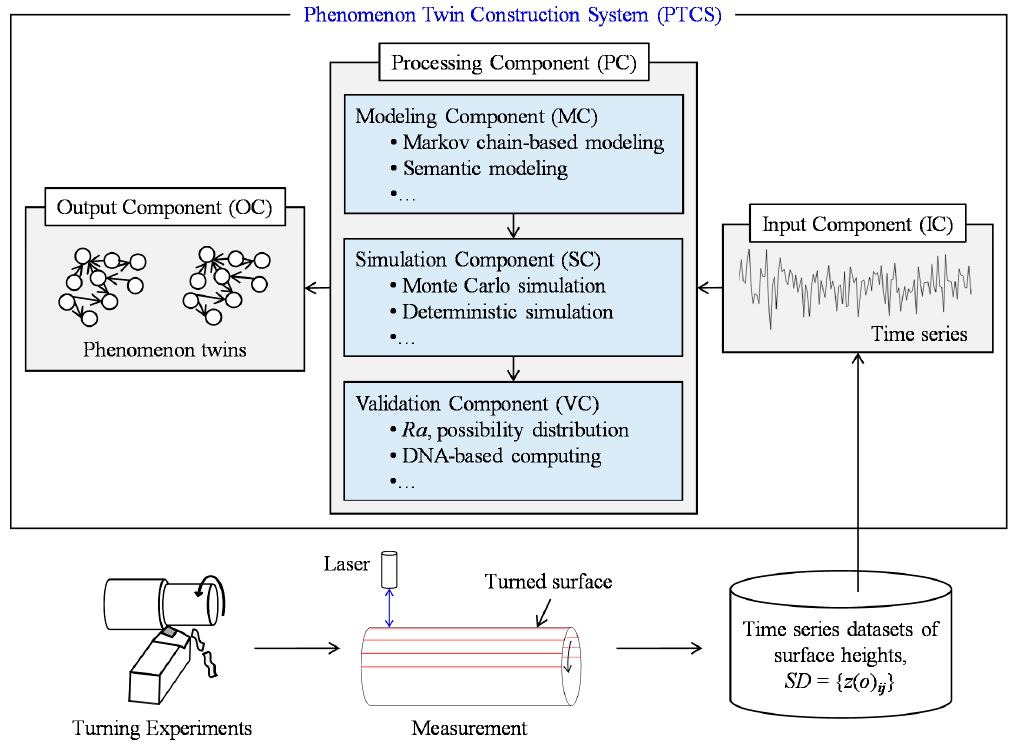
Figure 3. Outlining the phenomenon twin construction of surface roughness.